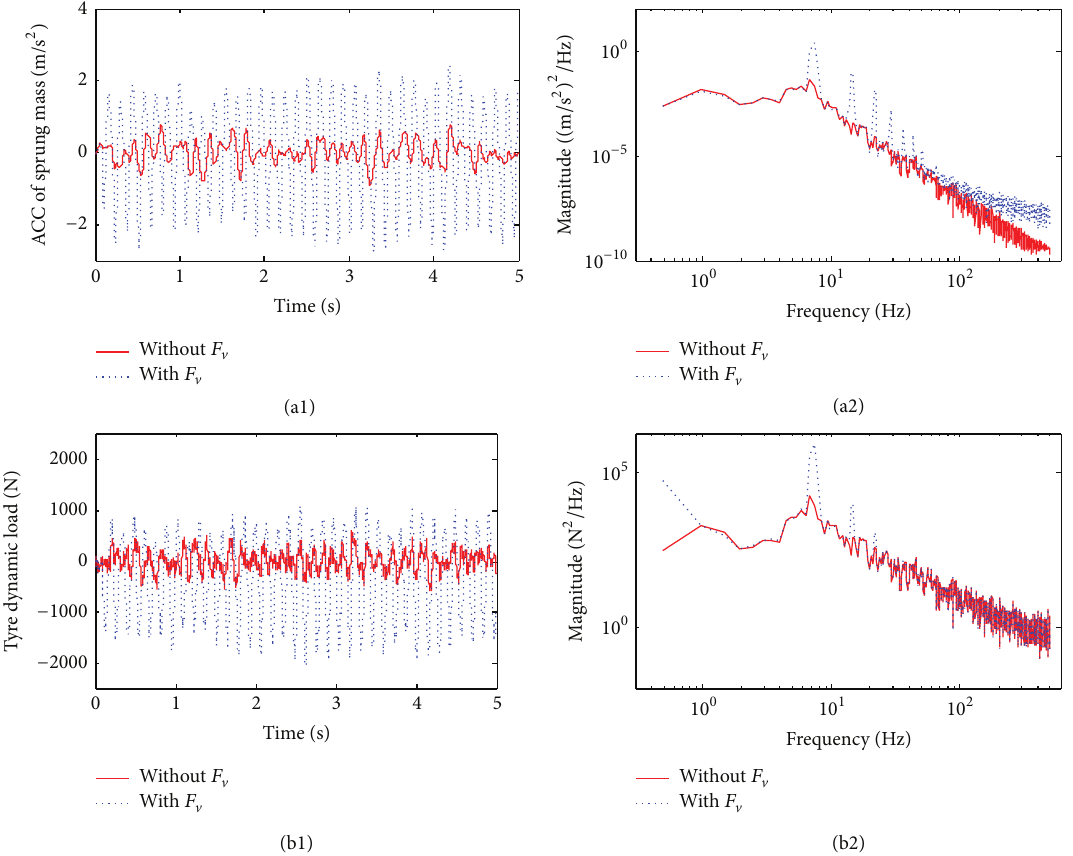
Figure 9: Suspension response to SRM vertical force at velocity 11km/h. (a1) Time history of sprung mass acceleration. (a2) PSD of sprung mass acceleration. (b1) Time history of tyre dynamic load. (b2) PSD of tyre dynamic